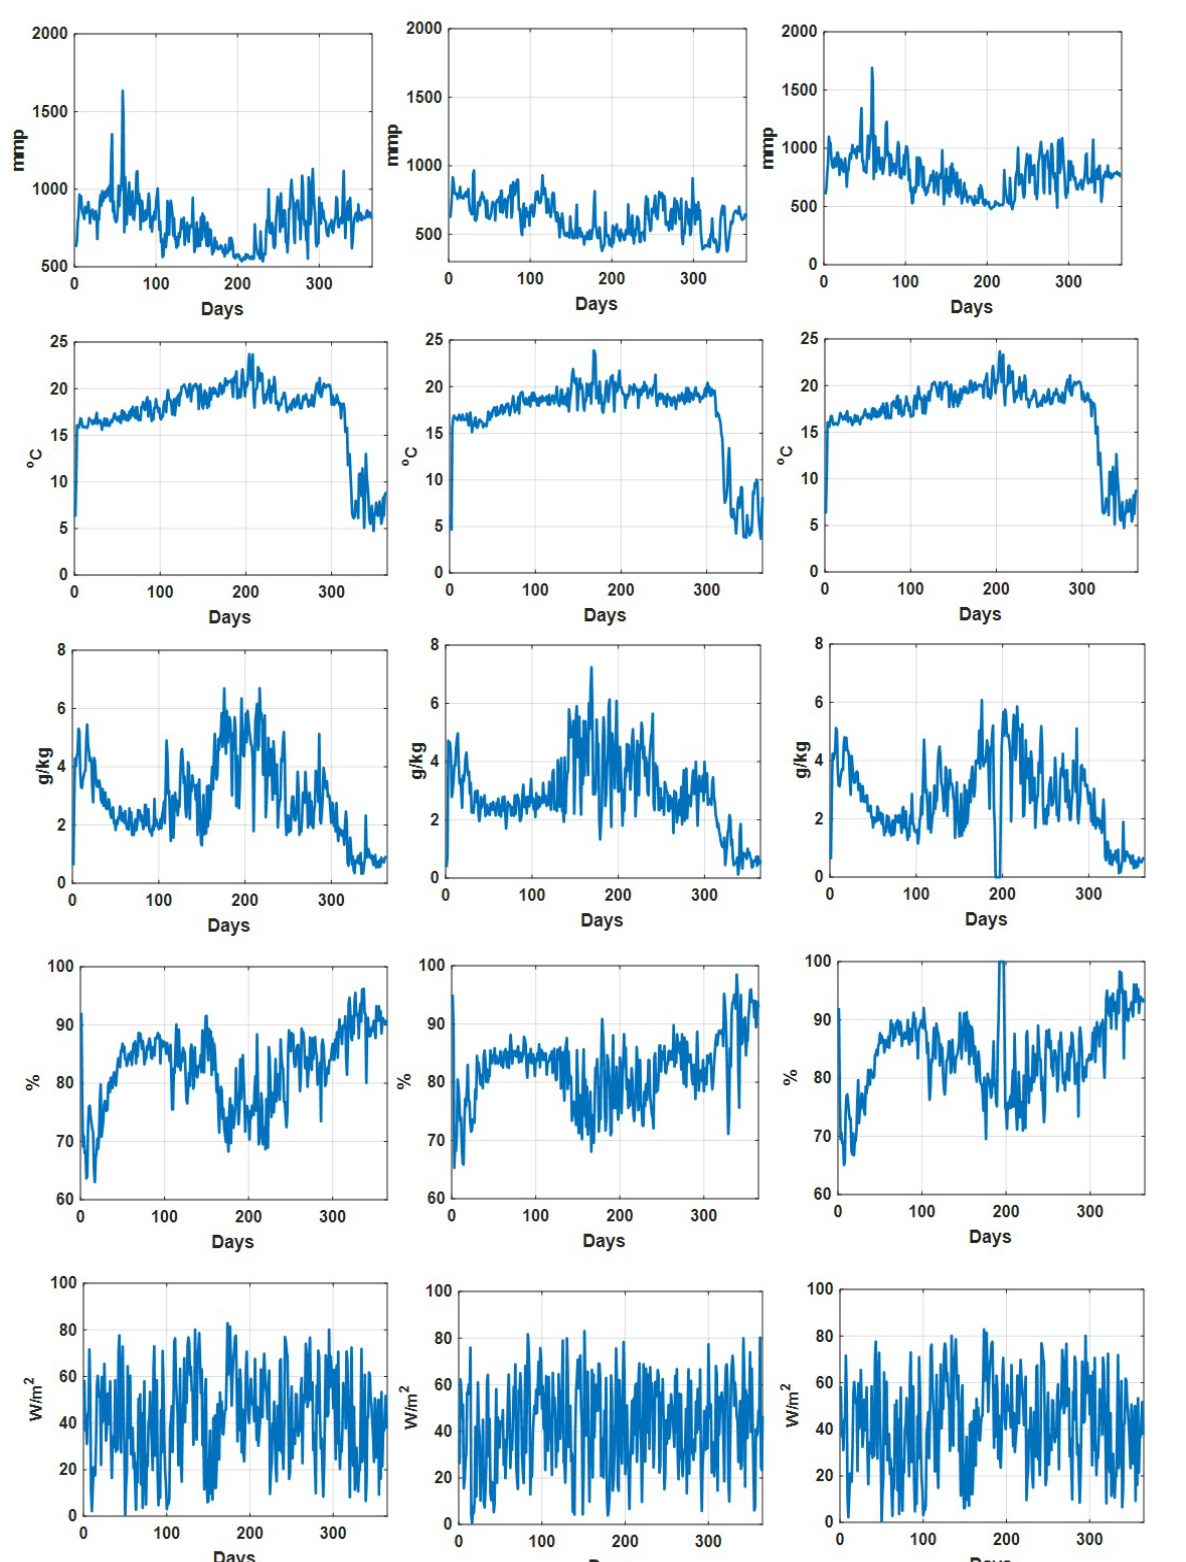
Figure 2. Daily recorded CO 2 concentration (mmp), temperature ( ◦ C), humidity deficit (g/kg), relative humidity (percentage) and radiation (W/m 2 ) associated with dataset 1 ( left column ), dataset 2 ( middle column ) and dataset 3 ( right column